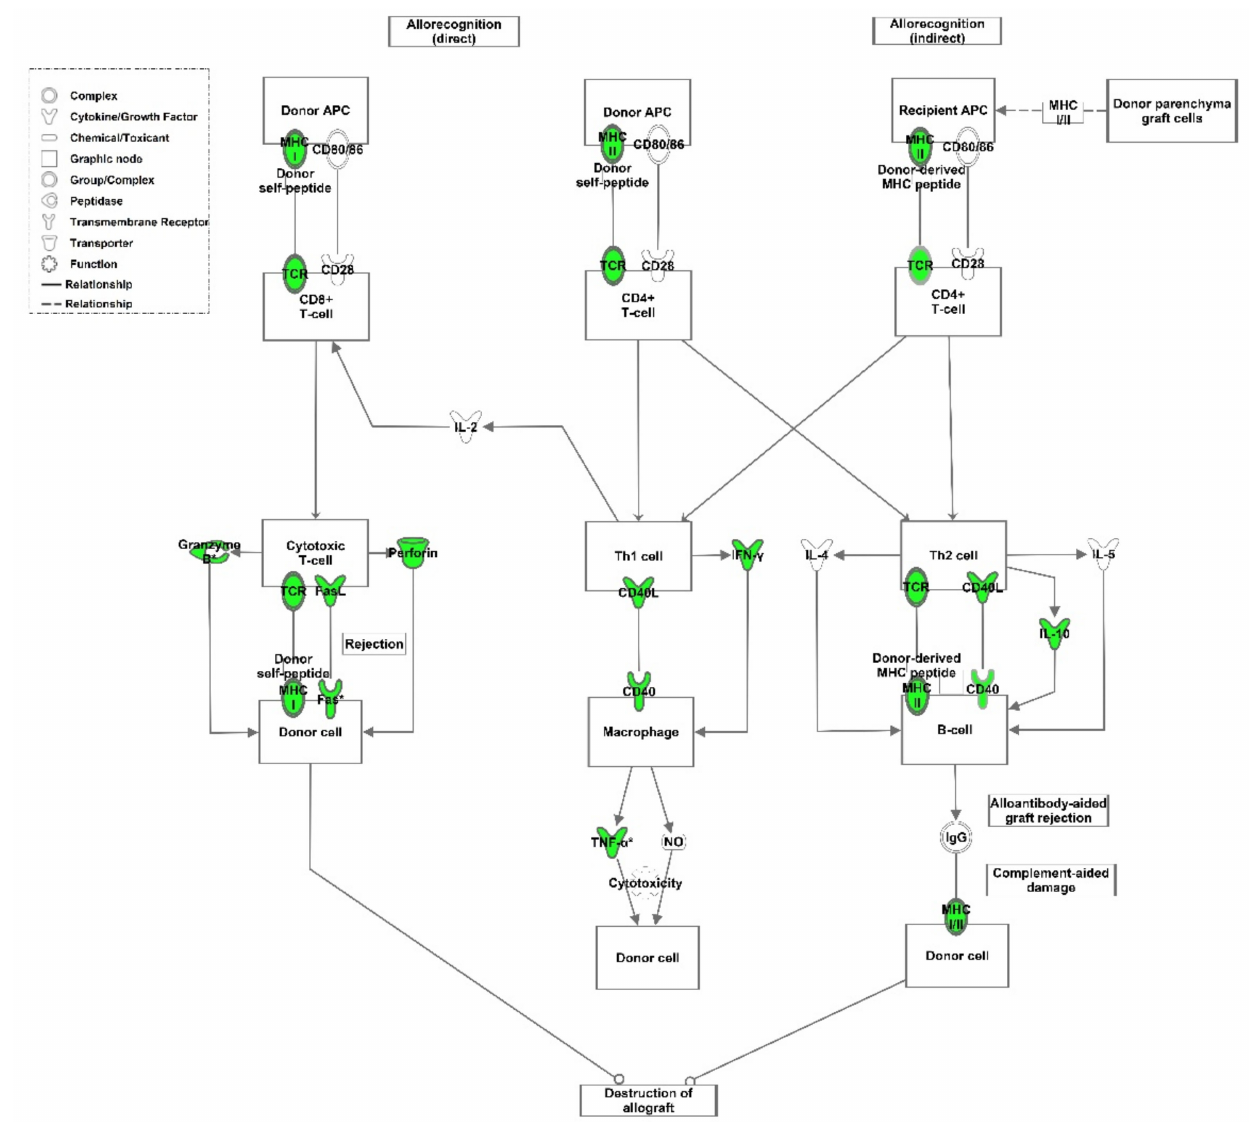
Figure 5. Induced expression of genes involved in allorecognition signalling. Ingenuity Pathways Knowledge Base was used to display pathways containing multiple differently expressed genes. Significantly regulated genes after allogeneic transplantation compared to syngeneic transplantation were mapped with the allograft signalling pathway. The lines indicate the type of relationships. Solid lines indicate a direct and dotted lines an indirect interaction. Upregulated genes are highlighted in